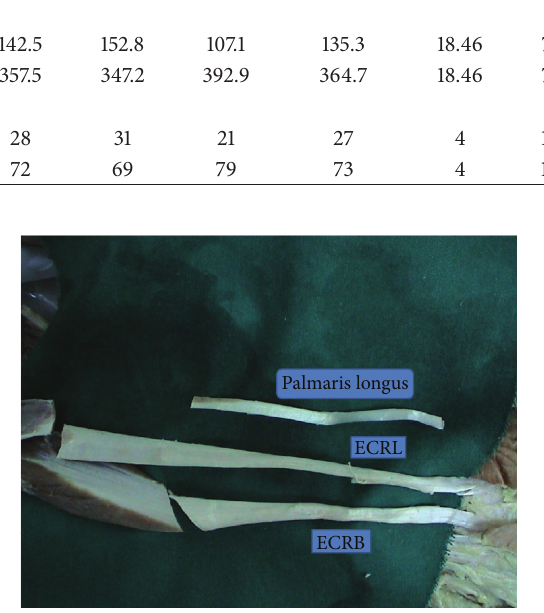
Figure 7: ECRL, ECRB, and palmaris longus